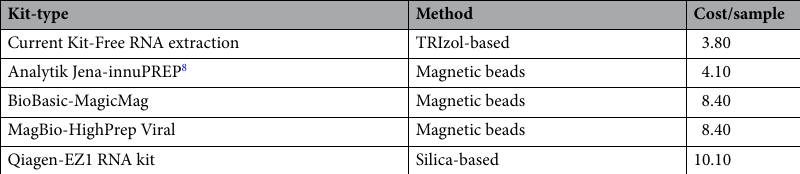
and mixed slowly by pipetting 5 times. An equal volume, or 80 μl, of isopropanol was added next, mixed slowly